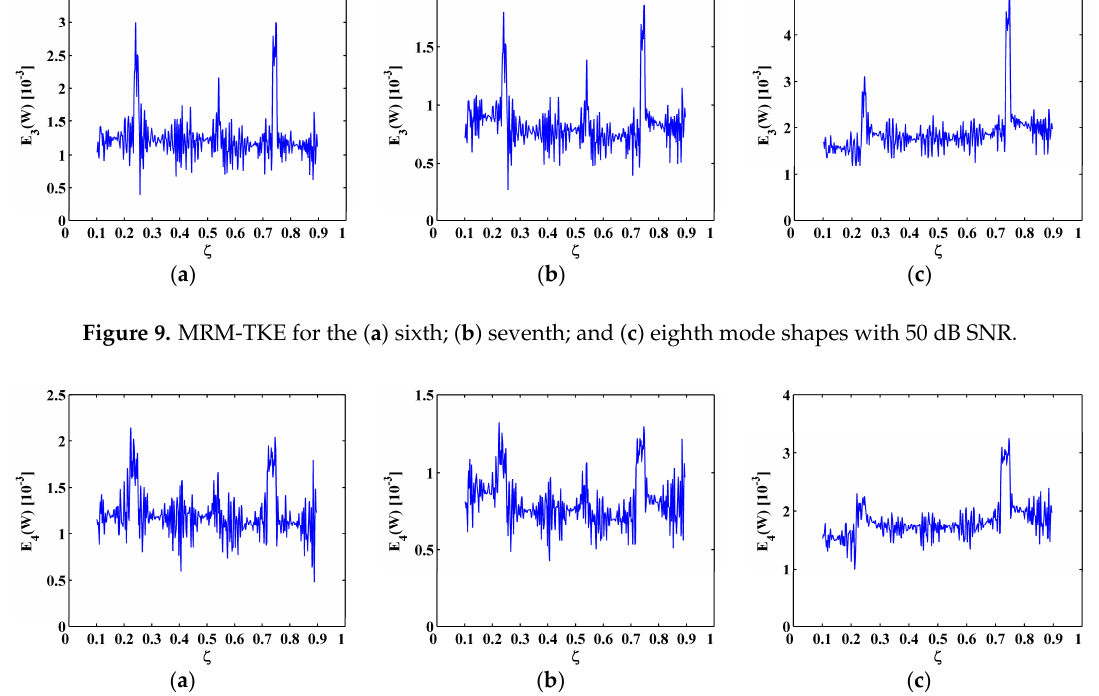
( c ) Figure 11. Modal curvatures for the ( a ) sixth; ( b ) seventh; and ( c ) eighth mode shapes with 45 dB SNR. 5. Experimental Validation The applicability of the MRM-TKE to the identification of cracks is experimentally validated on a CFRP laminated beam, whose modes shapes are acquired via non-contact measurement using a SLV. 5.1. Setup A CFRP laminated beam of length 500 mm, width 10 mm, and depth 1.5 mm, consisting of five plies each 0.3 mm in thickness, is taken as an experimental specimen. The dimensions of the beam are shown in Figure 12 in millimeters. As shown in Figure 12, the beam is clamped at the left end with the fixing area spanning 10 mm from the left edge. Four damage scenarios, Scenarios I, II, III and IV, are considered. First, three through-width cracks are manufactured in the first two plies on the surface, about 0.5 mm ( =1/3 